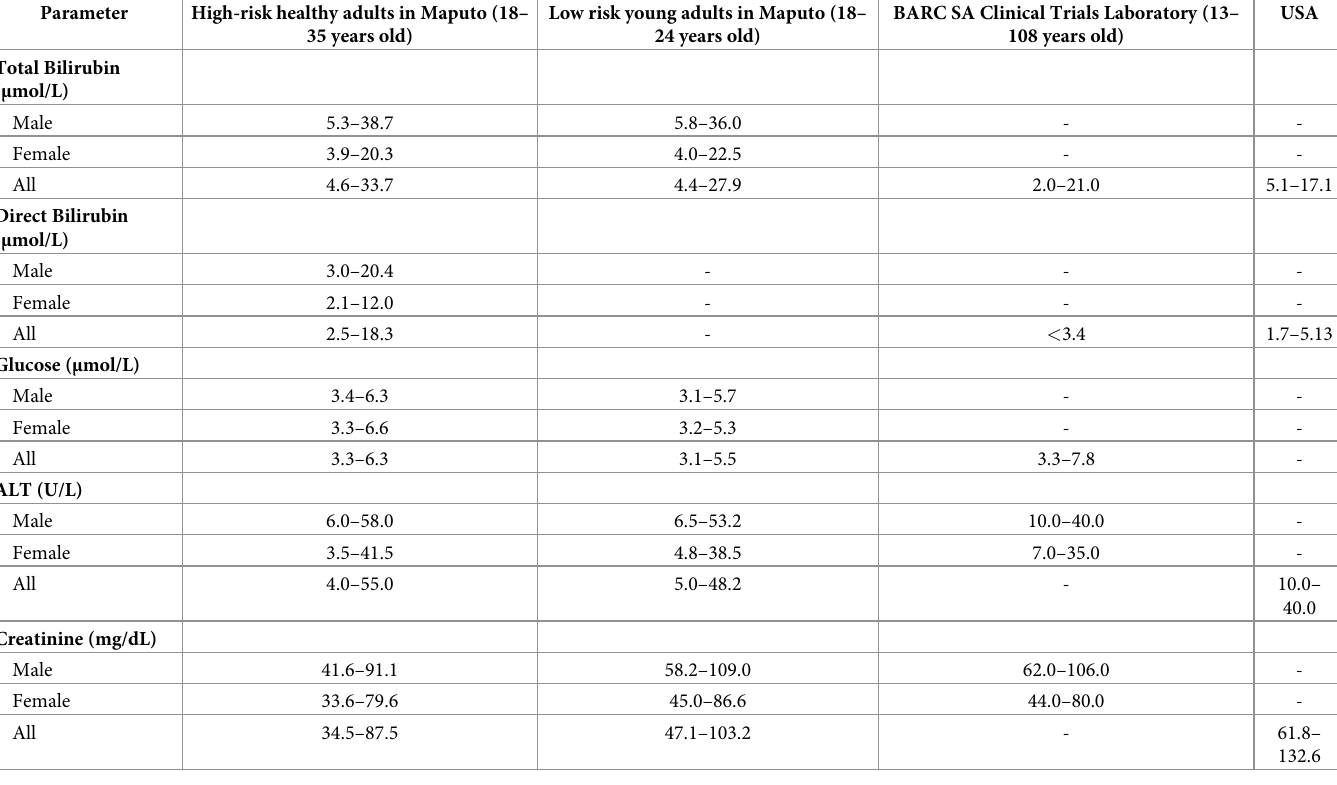
Table 6. Chemistry reference ranges derived from healthy adults at high-risk for HIV in Mozambique compared with local (low risk healthy adults), regional (SA) and international countries (USA). Parameter